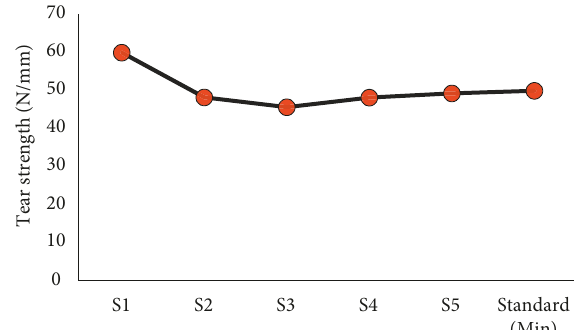
Figure 6: Shrinkage temperatures of the pickled skin